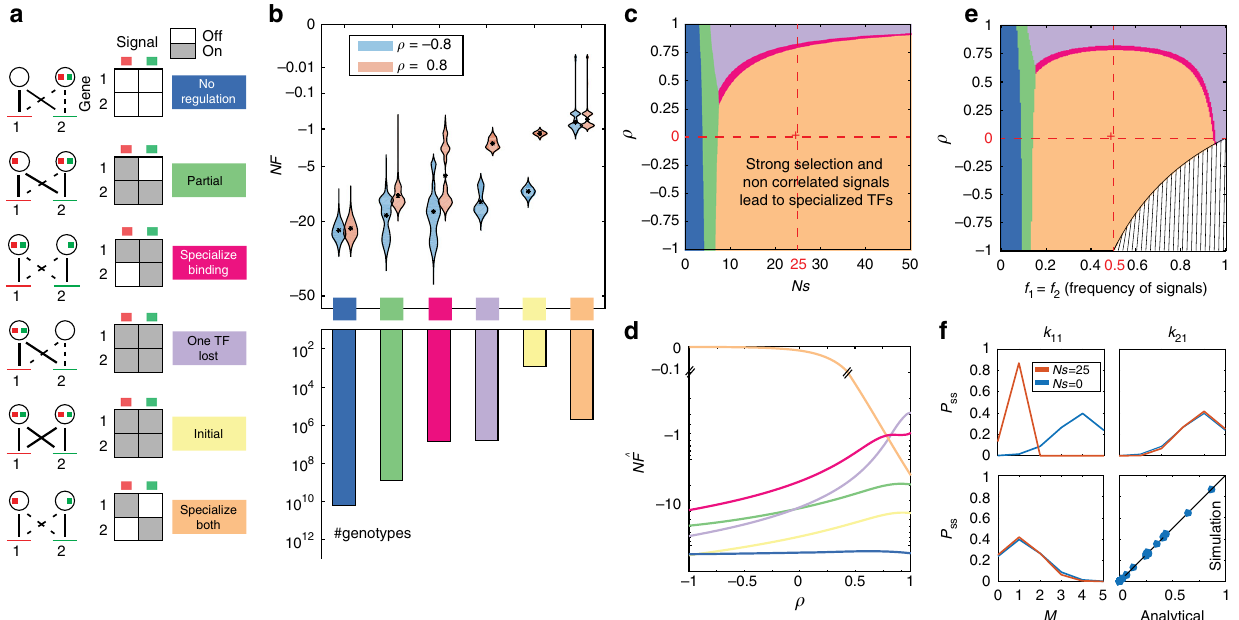
Fig. 3 Steady state evolutionary outcomes of TF duplication. a Left : evolutionary macrostates (see text) depicted graphically as network phenotypes with solid ( dashed ) lines indicating strong (weak) TF – BS interactions. Red and green squares in the TFs represent the corresponding signal sensing domains. Right : input – output table, where columns represent the presence of either ( red or green ) external signal and rows represent the resulting gene activation for each phenotype. b ( Top ) Distribution of fi tness values across genotypes in each macrostate (color-coded as in a ), shown as violin plots , for two values of signal correlation, ρ . Black dots = median fi tness in the macrostate. ( Bottom ) The number of genotypes in each macrostate (logarithmic scale). c Most probable outcome of gene duplication in steady state (color-coded as in a ), as a function of selection strength, Ns , and the correlation between two external signals, ρ . d Free fi tness ^ F (at Ns = 25) for different macrostates as a function of correlation between signals, ρ : for most macrostates, free fi tness increases with signal correlation, except for ‘ No regulation ’ , which is naturally unaffected by it, and ‘ Specialize Both ’ , which dominates for low correlation values. e The dominant macrostate (as in c ), as a function of the signal frequencies, f 1 , f 2 , and the signal correlation, ρ , at fi xed Ns = 25. For simplicity we plot only cases where f 1 = f 2 . Signals in the hashed region are mathematically impossible. f Steady state distributions for mismatches ( P SS ( k ij | σ 1 = 10, σ 2 = 01), upper row) and the match between the two TF consensus sequences ( P SS ( M | σ 1 = 10, σ 2 = 01), lower left), under strong selection ( red ; at baseline parameters denoted by the red cross in c ) and neutrality ( blue ; Bernoulli distributions). Comparison between analytical calculation and 400 replicates of the stochastic simulation ( lower right ). Here and in subsequent fi gures, baseline parameter values are L = 5, ϵ = 3, r S = r TF =